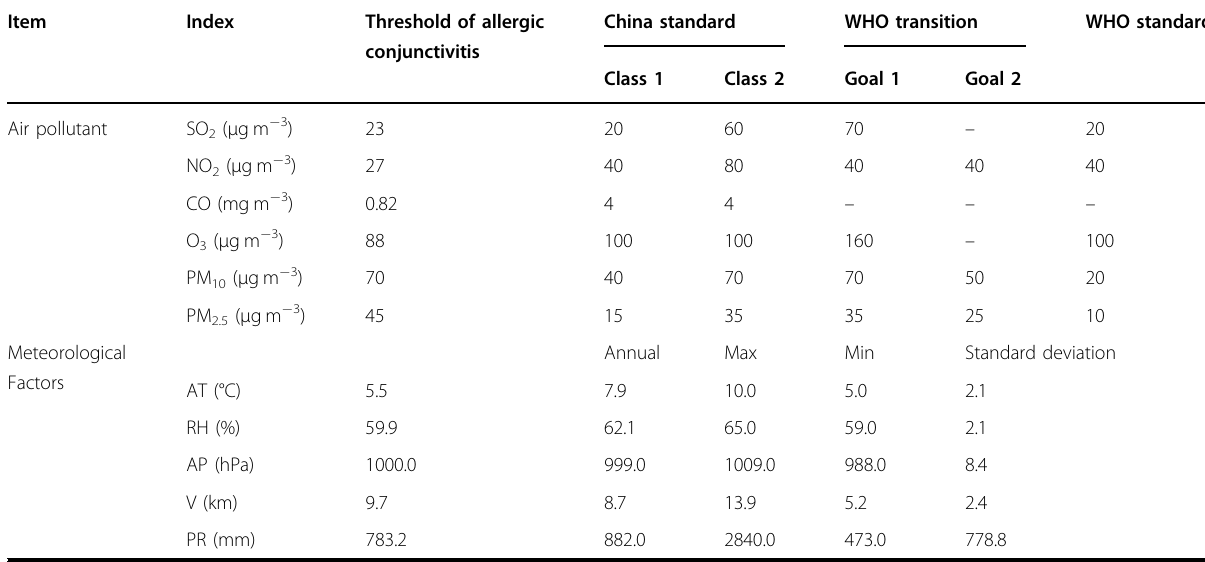
Table 3 The threshold of environmental factors for the IAC and corresponding criteria in China and WHO